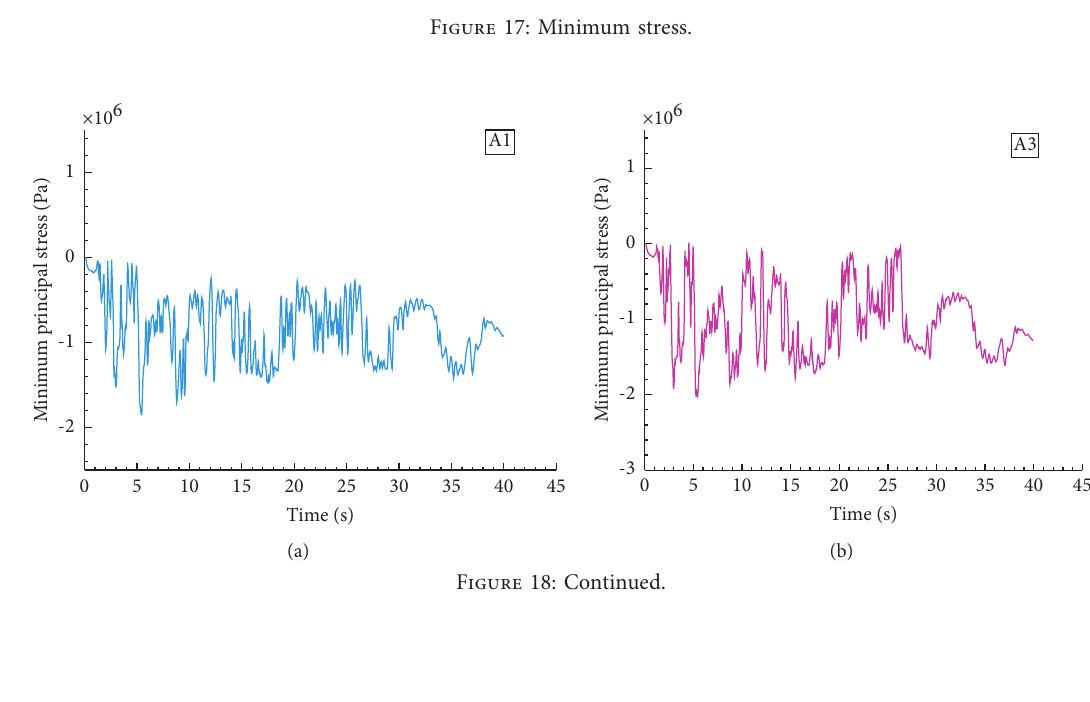
Figure 17: Minimum stress.